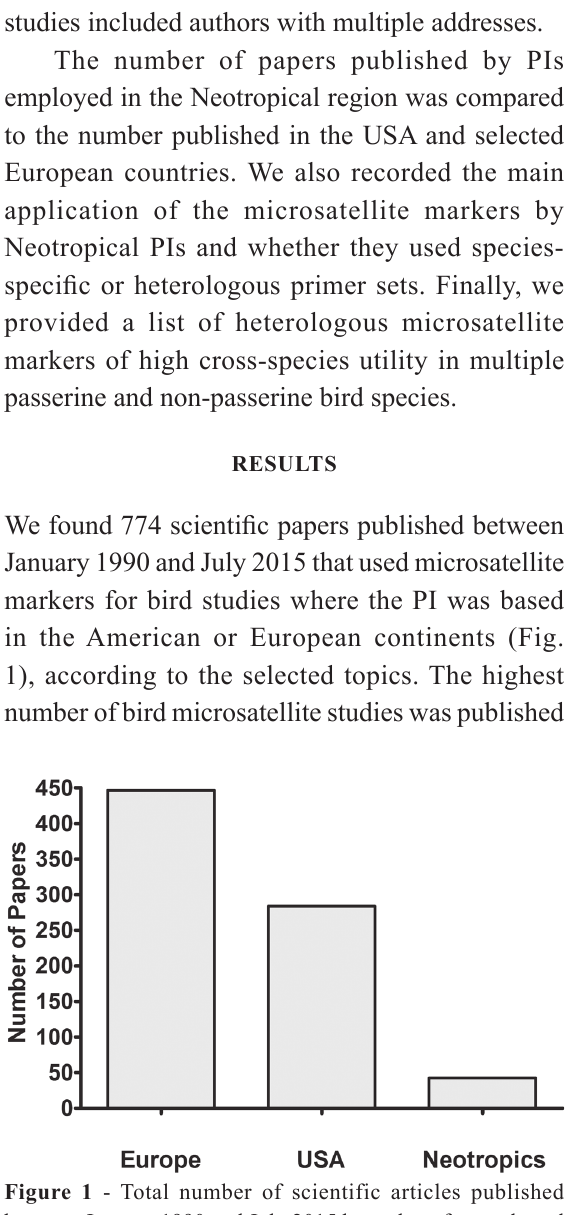
Figure 2 - Total number of scientific articles published between January 1990 and July 2015 by authors from the Neotropical region that used microsatellite markers for studies of birds, involving population genetics, behavior/kinship and/or the characterization of microsatellites markers.